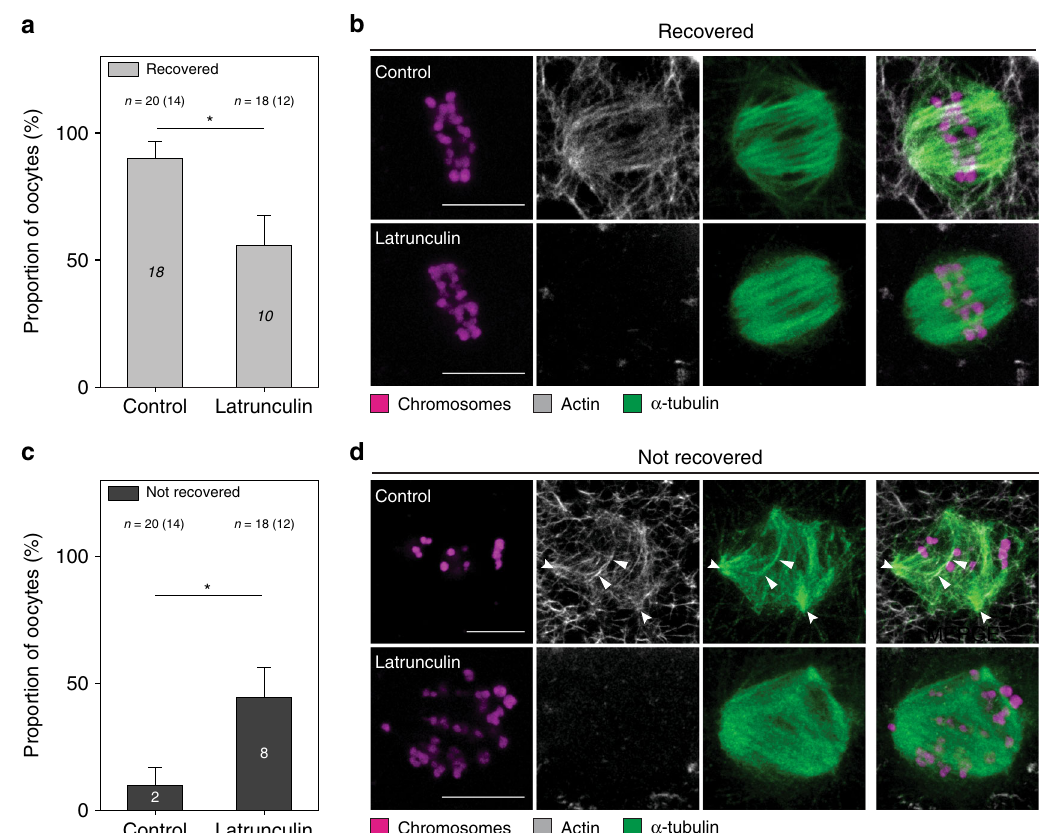
Fig. 5 Actin supports microtubules in the assembly of a bipolar spindle. a Proportion of oocytes that restored bipolar spindle morphology (recovered) in the absence or presence of 1 µ M latrunculin-B after nocodazole treatment. b Representative z -projections of recovered MII oocytes after nocodazole treatment and 60 to 90 min regeneration time in the absence or presence of 1 µ M latrunculin-B showing chromosomes (Hoechst), α -tubulin, and actin (phalloidin); z = 4 sections. Representative of n = 15 (upper panel) and n = 10 (lower panel) oocytes. c Proportion of oocytes that retained spindle multipolarity (not recovered) in the absence or presence of 1 µ M latrunculin-B after nocodazole treatment. d Representative z -projections of not recovered MII oocytes after nocodazole treatment and 60 to 90 min regeneration time in the absence or presence of 1 µ M latrunculin-B showing chromosomes (Hoechst), α -tubulin, and actin (phalloidin). Arrowheads highlight actin-microtubule overlap; z = 4 and 5 sections. Representative of n = 2 (upper panel) and n = 8 (lower panel) oocytes. Scale bars, 10 μ m. n = total number of oocytes. The number of donors is speci fi ed within parentheses. Error bars represent standard error of the mean. Signi fi cance was tested using Fisher ’ s exact test. Asterisks denote p -values: * < 0.05. Source data are provided as a Source Data fi